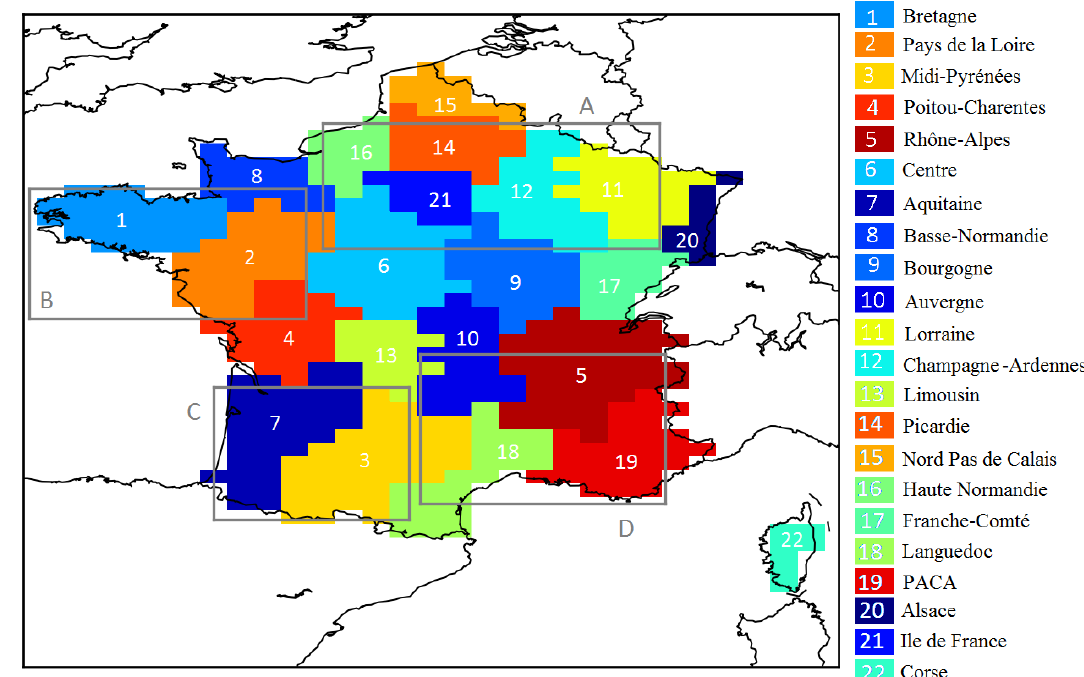
Figure 2. Localization and names of the different French regions as taken into account in this study. The regions are listed according to the TNO-GEN annual budget, in descending order. The grey boxes A–D describe the domains we call the northeastern, northwestern, southeastern and southwestern parts of France, respectively, in the